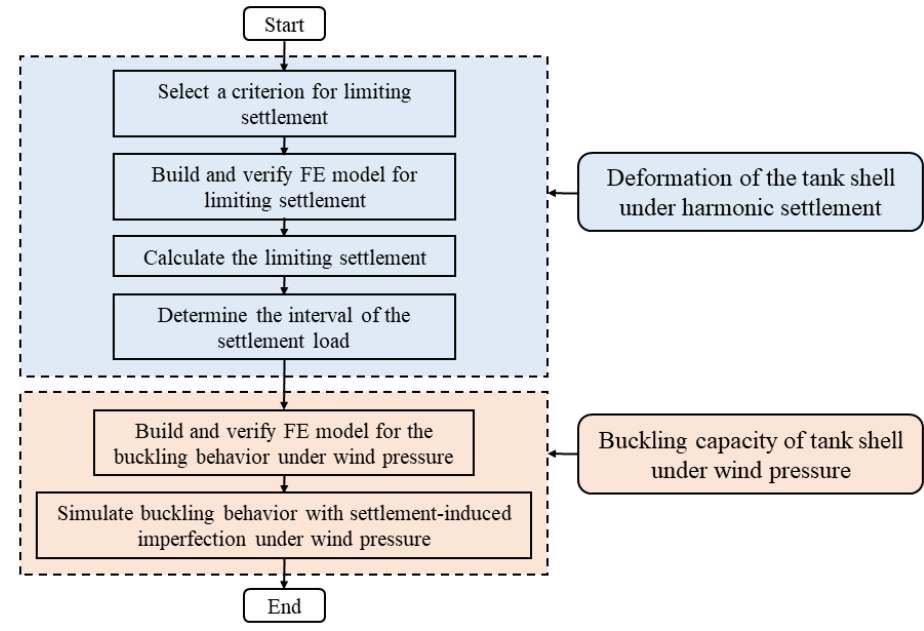
Figure 2. Flowchart of the analysis procedure.